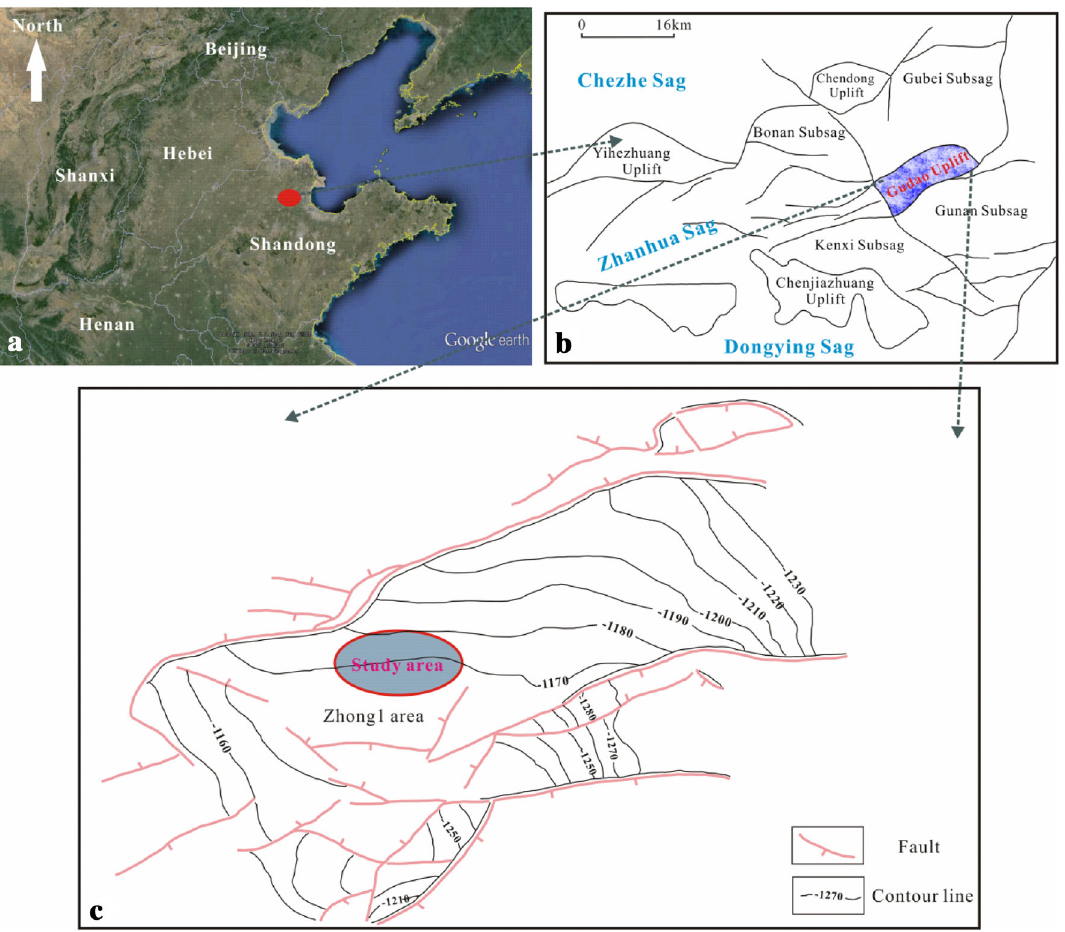
Fig. 1 Structural position map of the study area. a Location of Zhanhua sag in Jiyang depression in Bohai bay basin in China. b Location of Gudao uplift in Zhanhua sag. c Study of Zhong1 area in Gudao Oil field and the faults distribution in Gudao Oil